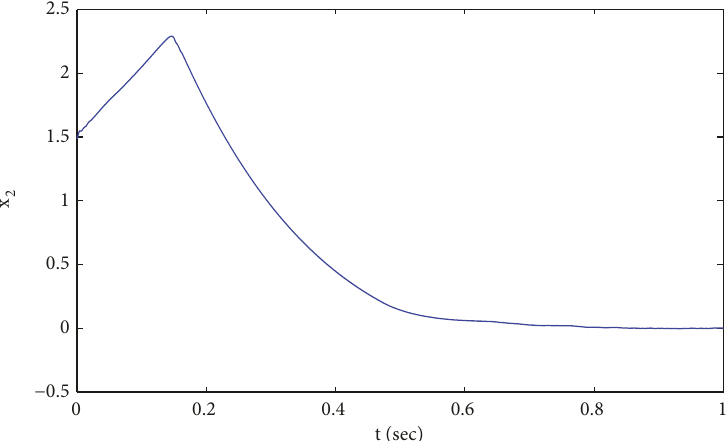
Figure 3: The time response of state 𝑥 2 of system (36) with controller (37).